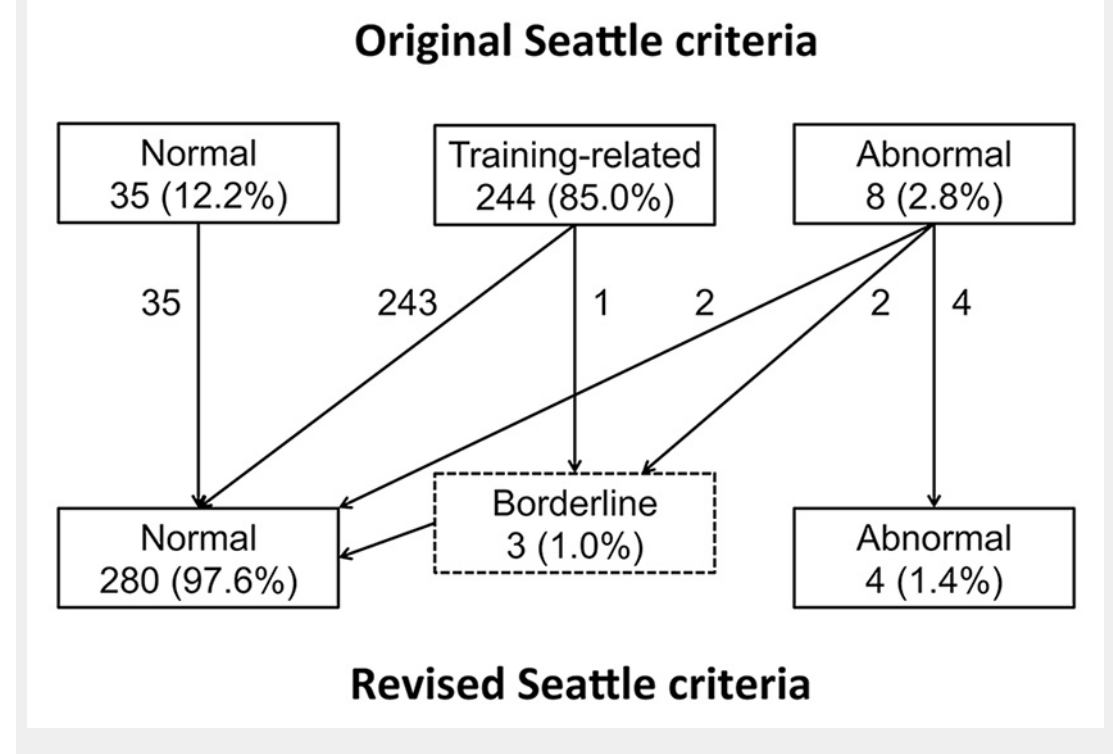
Figure 2 Allocation of ECG changes according to the original and revised Seattle